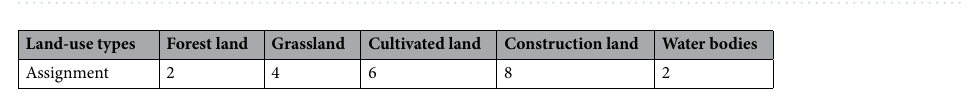
Table 2. Standardized grading assignment of land-use